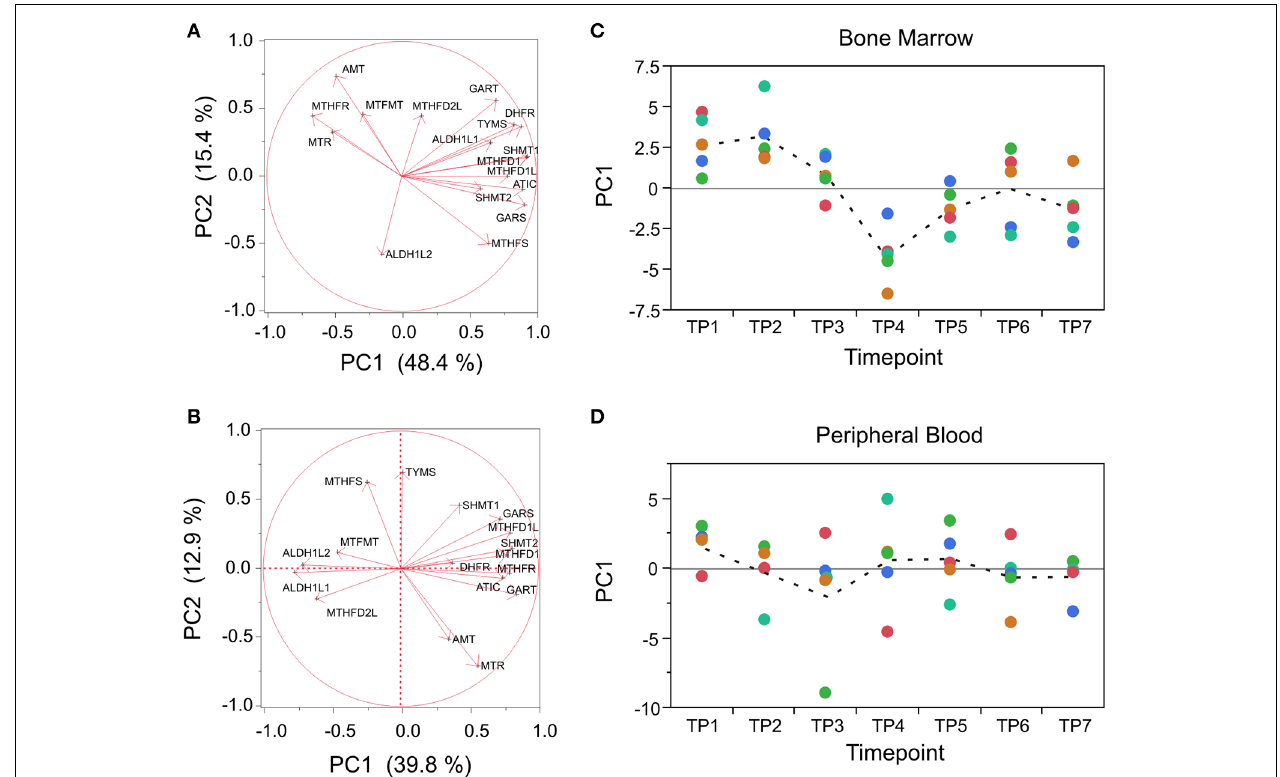
FIGURE 7 | Targeted analysis of the folate pathway. (A,B) Loadings of the first two PC for each of 17 genes in KEGG map00670 (One carbon pool by folate) in BM and PB, also indicating the percent variation explained by each PC. Note that MTHFR switches direction effect